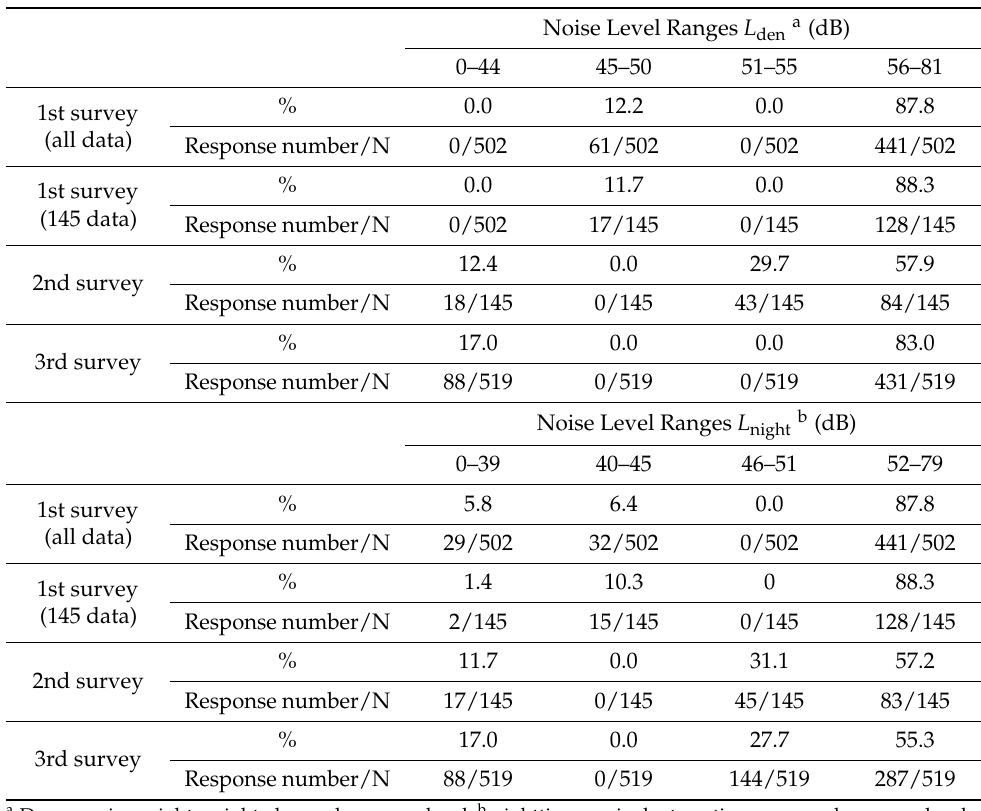
Table 5. Comparison of number of responses across different noise level ranges in the three